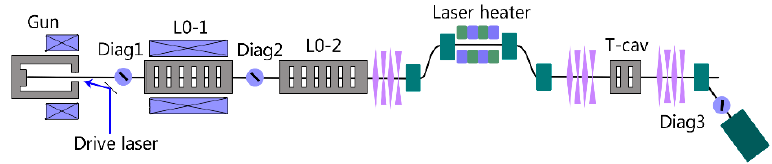
Figure 2 . Layout of the SXFEL injector. (Reprint from reference [26]) Figure 2. Layout of the SXFEL injector. (Reprint from reference [26]).